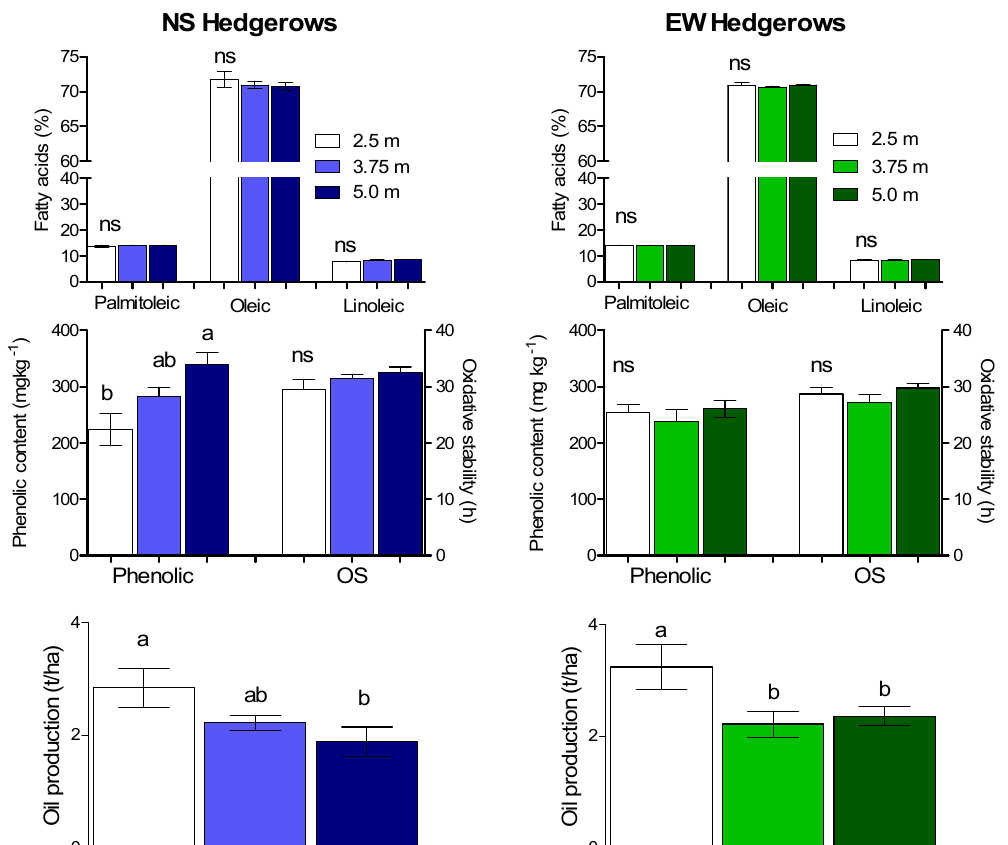
Figure 2. Weighted mean concentrations of main fatty acids and phenolic concentrations together with the oxidative stability (OS) of oils extracted from 2.4-m tall × 1.2-m wide NS ( left ) and EW ( right ) hedgerows of cv. Arbequina planted at three row spacings (5.0, 3.75 and 2.5 m). Each bar is the average of the 2012 and 2013 seasons in Toledo, Spain. The average oil production per ha during 2012 and 2013 is also shown. NS and EW results were independently subjected to ANOVA. Columns labelled ns are not statistically different; those with different letters are at p < 0.05.